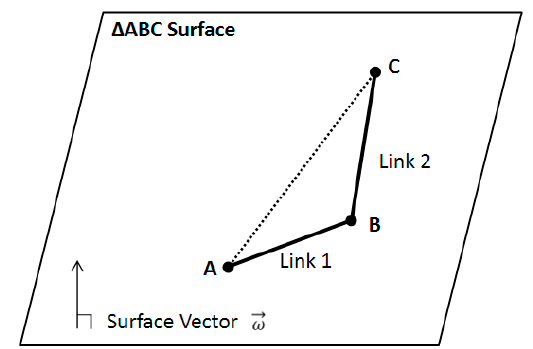
Figure 6. Simple linkage model of two links.